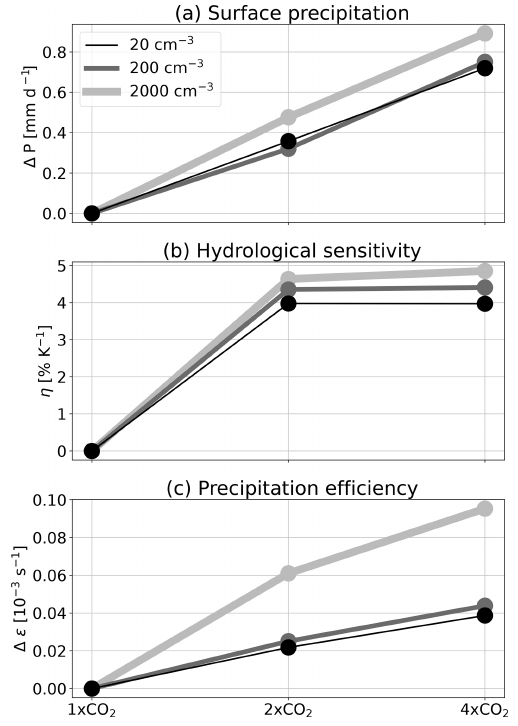
Figure 5. The change in (a) surface precipitation, (b) hydrological sensitivity ( η ) and (c) precipitation efficiency ( (cid:15) ) due to a change in the CO 2 concentration (compared to the 1 × CO 2 case of each aerosol concentration), for the different aerosol concentrations (the different